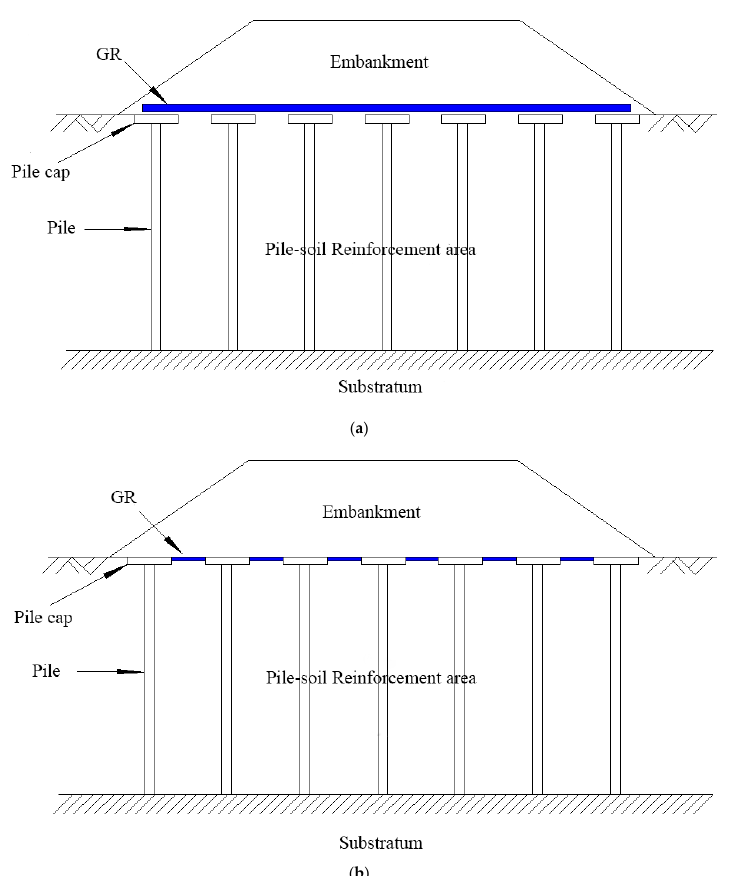
Figure 4. Structural design of a GRPSE system using ( a ) traditional and ( b ) proposed new construc- tion methods.